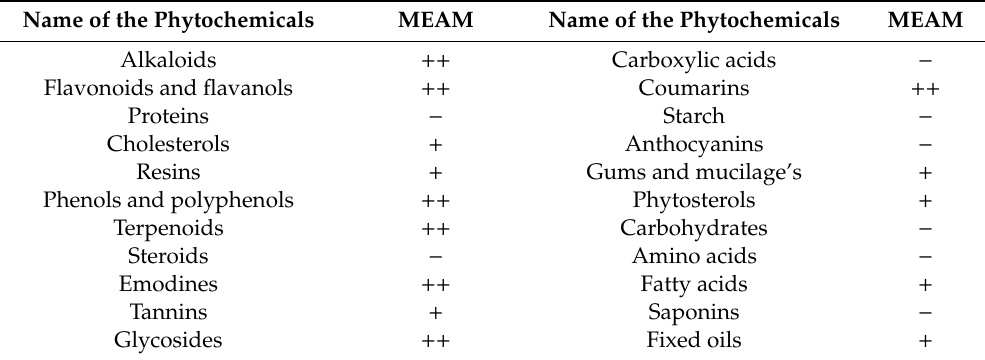
Table 1. Qualitative phytochemical analysis of MEAM leaves.